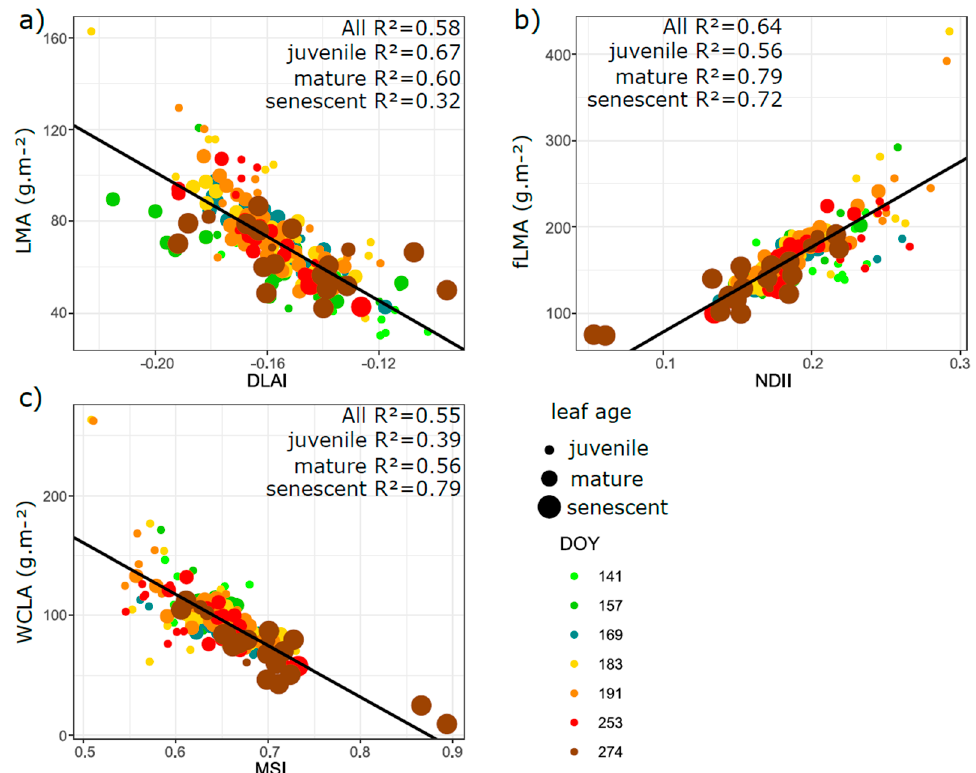
Figure 12. Linear relationship between best-performing vegetation index and a leaf structural trait ( a ) DLAI index (R1724.7 − R970.5) and LMA: leaf mas per area; ( b ) NDII ((R818.9 − R1648.5)/(R818.9 + R1648.5)) and fLMA: fresh leaf mass per area; ( c ) MSI (R1600.8/R818.9) and WCLA: water content per leaf area. Different size of circles corresponds to leaf age (juvenile—small, mature—middle, and senescent leaves—large). Different colors correspond to individual DOYs during the season. Coefficient of determination (R 2 ) is shown for all leaf developmental stages pooled together (All); juvenile, mature, and senescent leaves separately.